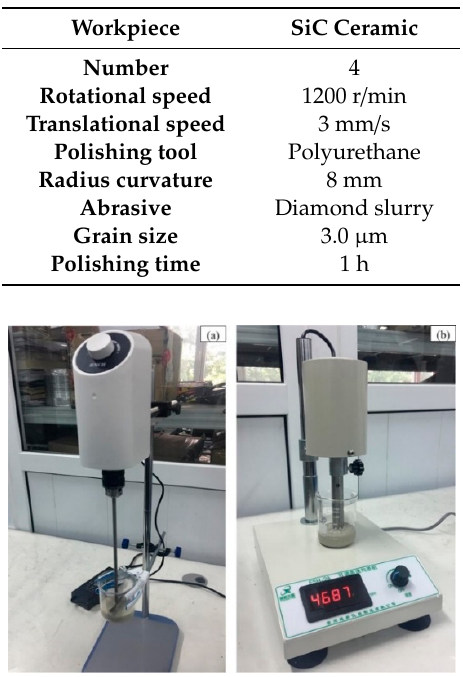
Figure 17. Stability control device of the diamond slurry. ( a ) Agitator and ( b ) high speed homogenizer.